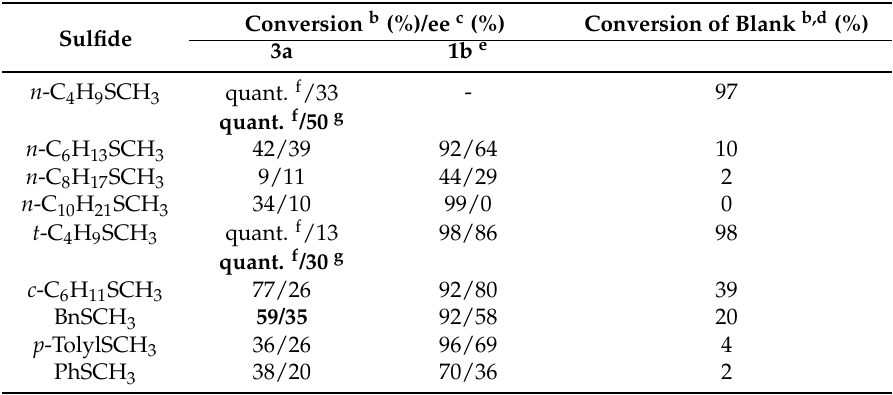
Table 2. H 2 O 2 -sulfoxidations catalyzed by conjugate 3a and comparison with data for 1b and non-catalyzed reaction a . Conversion b (%)/ee c (%) Conversion of Blank b,d Sulfide